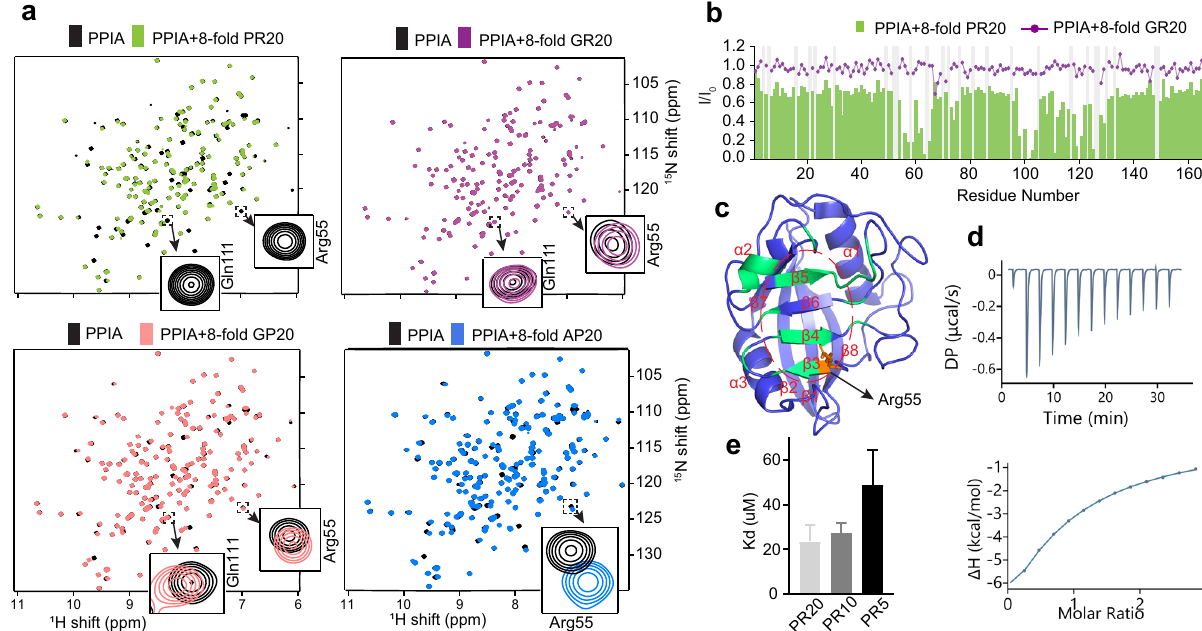
Fig. 2 PR repeat polymers bind to the active site of PPIA. a 1 H – 15 N HSQC spectra of PPIA alone (black) and in the presence of an eightfold excess of PR20 (green), GR20 (magenta), GP20 (red), and AP20 (blue). Cross-peaks of residues, which are located in the substrate-binding pocket of PPIA, are highlighted. b Changes in the intensities of HSQC peaks of PPIA upon addition of an eightfold excess of PR20 (bars). I and I 0 are the intensities of the PPIA cross-peaks in the presence and absence of PR20. No broadening was observed upon addition of an eightfold excess of GR20 (line). c PPIA residues with strong PR20-induced signal attenuation are highlighted in the 3D structure of PPIA (PDB code: 5KUZ; https://www.wwpdb.org/pdb?id = pdb_00005kuz). Arg55 is highlighted in orange. PPIA residues with I / I 0 values less than 0.394 (mean value of I / I 0 for all residues minus its standard deviation) upon addition of eightfold molar excess of PR20 are shown in green. The active site of PPIA is circled (dashed line). d Isothermal titration calorimetry thermogram of PR20 binding to PPIA. e K d values for the interaction of PPIA with PR20, PR10, and PR5 derived from the attenuation of the HSQC cross- peak of Arg55 of PPIA. Error bars represent the standard deviation in K d generated from least-square fi tting of experimental data to Eq. (1).